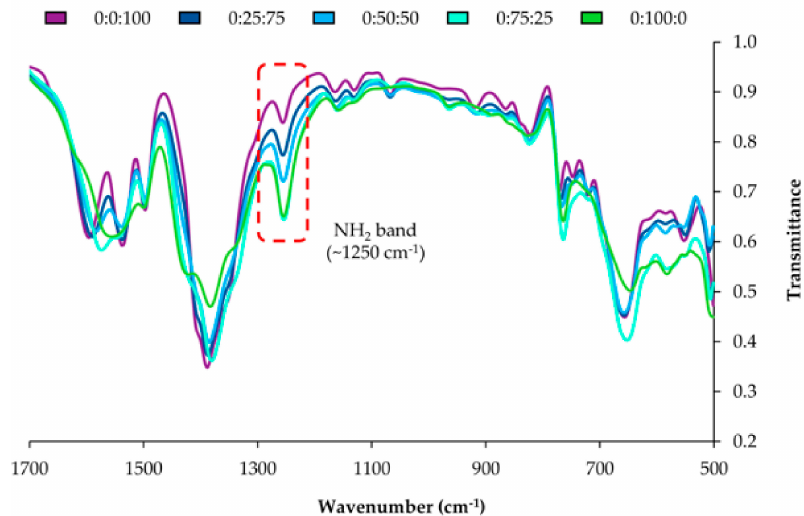
Figure 2. Zoom in the infrared spectra of the NO 2 -bdc / NH 2 -bdc series, from 500 to 1700 cm − 1 . The code H-bdc: NH 2 -bdc:NO 2 -bdc is included for each